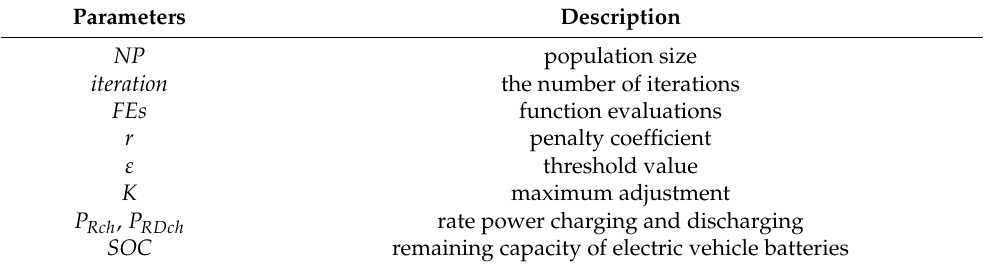
Table 1. Cont. Parameters Description NP population size iteration the number of iterations FEs function evaluations penalty coefficient